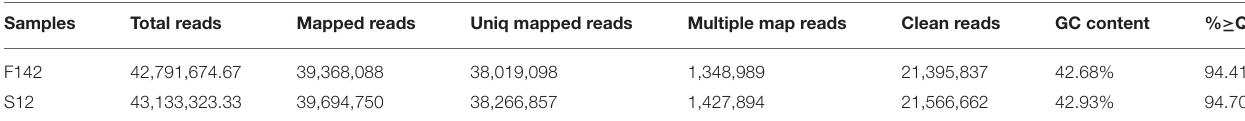
TABLE 1 | Statistical analysis of RNA-seq reads mapped to the ancestor genome. Samples